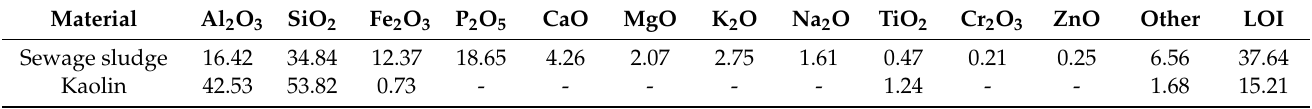
Table 1. Chemical compositions of sewage sludge and kaolin determined by XRF (wt.%).